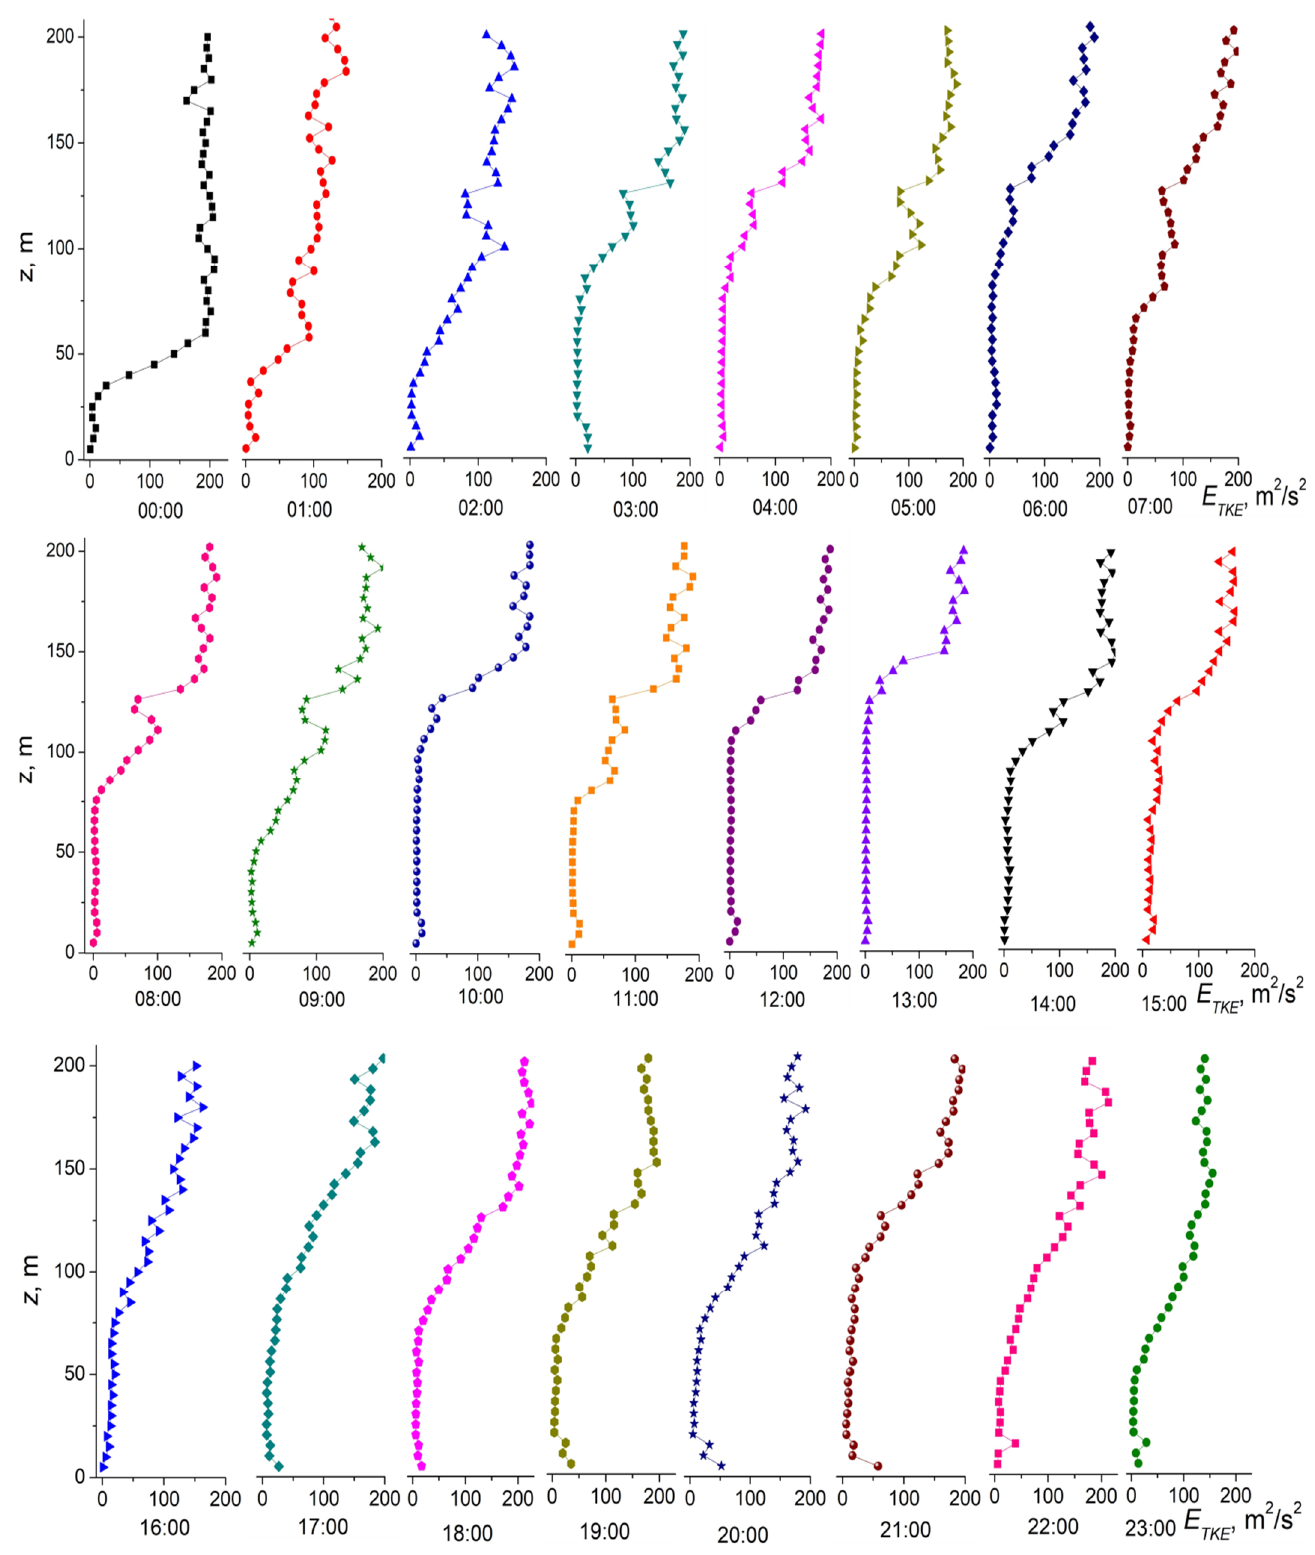
Figure 1. Diurnal hourly dynamics of the turbulent kinetic energy component retrieved from minisodar measurements with 10-min averaging. The start local time of measurement series is indicated in the lower right corner of the of the plots. z = 10–20 m, surface layer II with z = 25–172 m, layer III of linear TKE increase IT IIT to IIIT z = 70–185 m, and transitive layer IV above. In the near-ground layer, the TKE first